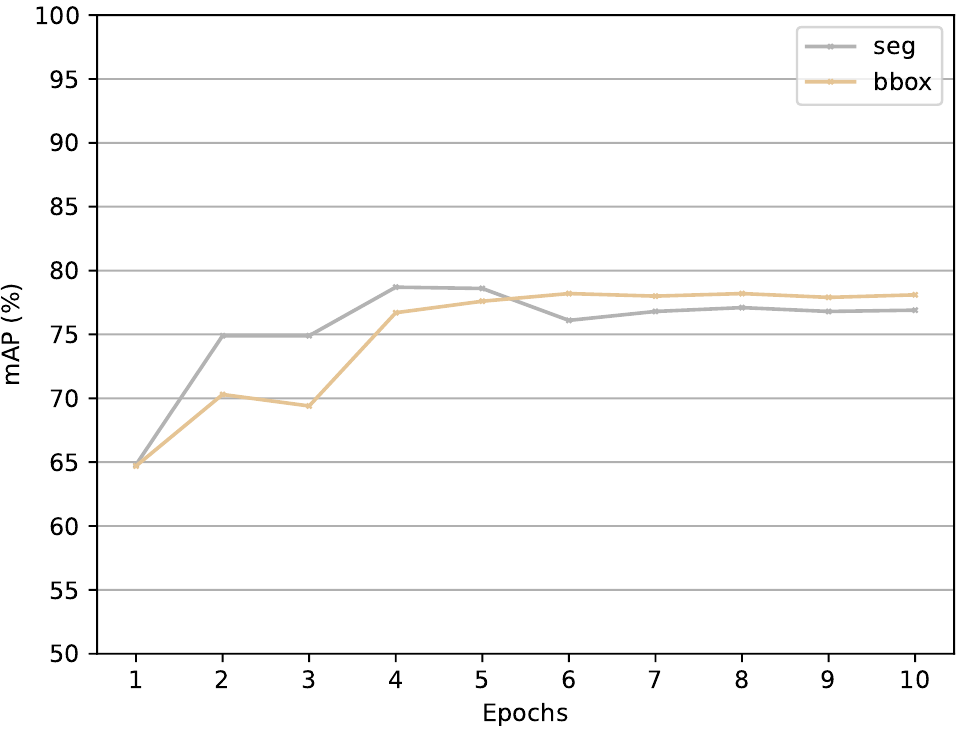
Figure 22. mAP with different levels of data augmentation used over epochs. Discussion: With no significant increase in mAP on the test set after 5 epochs, yielding only a slight increase in mAP for bounding and a decrease in mAP for